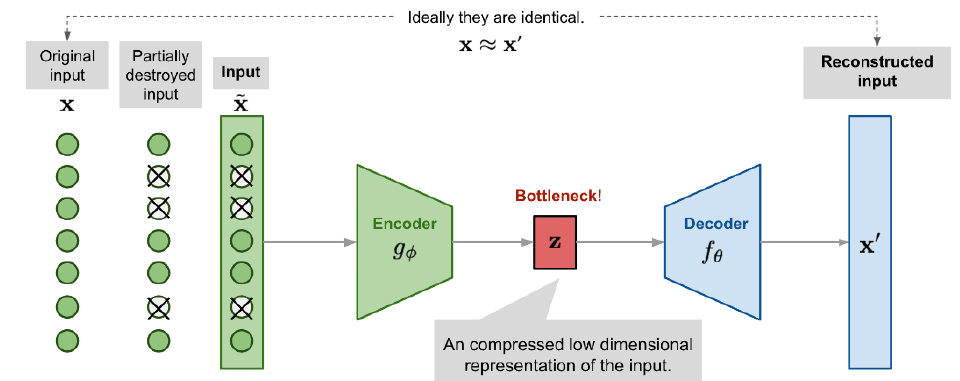
Figure 11. Illustration of denoising autoencoder model